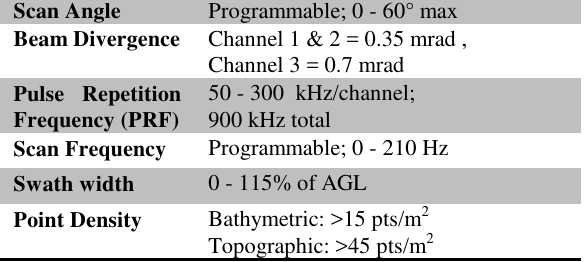
Table 1. Optech Titan sensor specifications